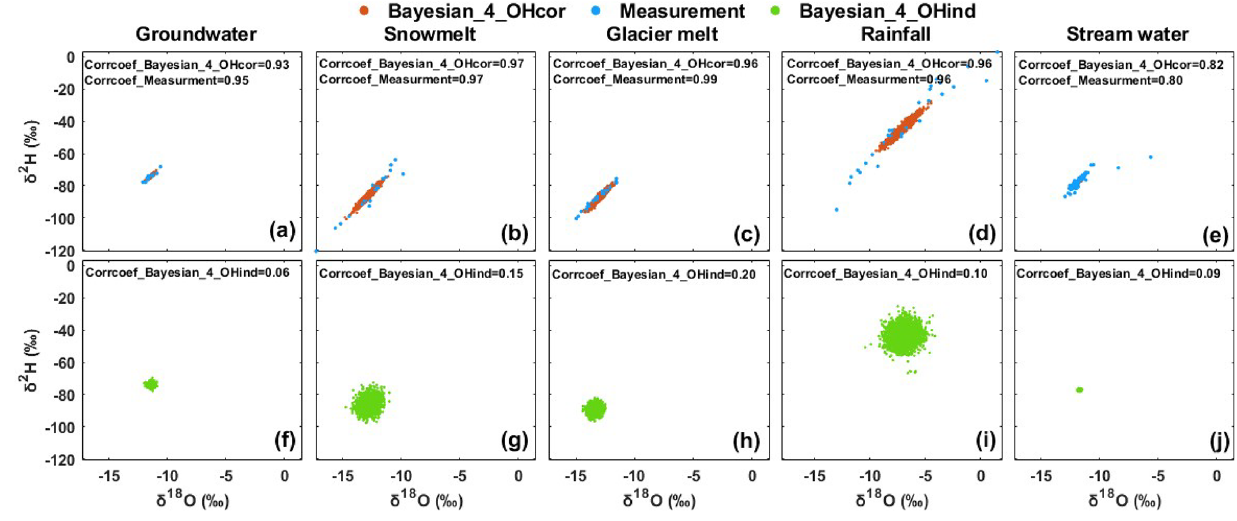
Figure 7. Correlation between posterior δ 18 O and δ 2 H estimated by the Bayesian_4_OHcor and the Bayesian_4_OHind approaches in the glacier melt season.